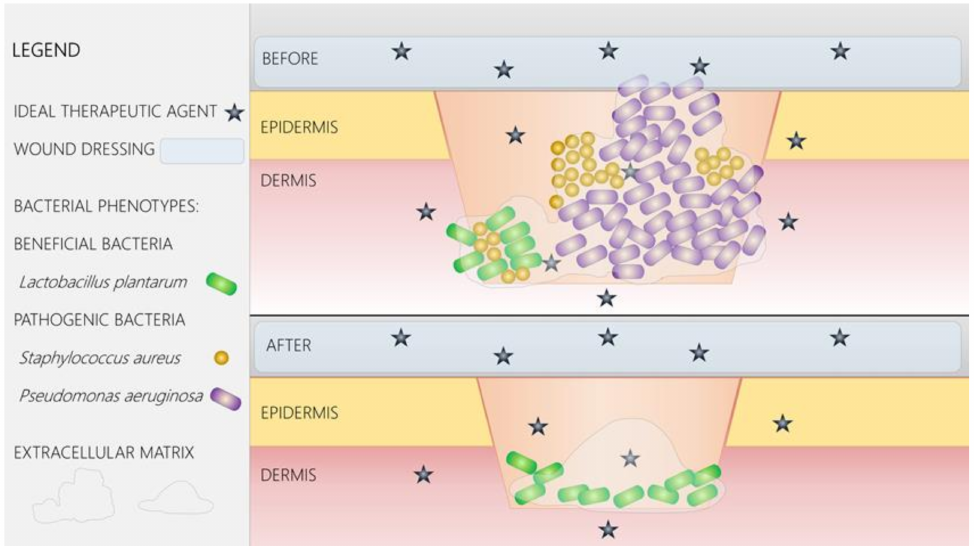
Figure 2. Nanoparticles embedded within bioactive wound dressings could enhance the delivery to the target of beneficial molecules with antimicrobial, immunomodulatory, and regenerative effects. In regard to the antimicrobial action, an ideal therapeutic agent should destroy pathogenic bacteria but also modulate microbial colonization, attachment, and biofilm development; modulate and promote beneficial bacterial phenotypes; modulate inter-bacterial and host-microbiome interactions. The agent should achieve immunomodulatory action by supporting the host’s defense mechanisms, as well as regenerative effects, by the enhancement of wound healing and tissue